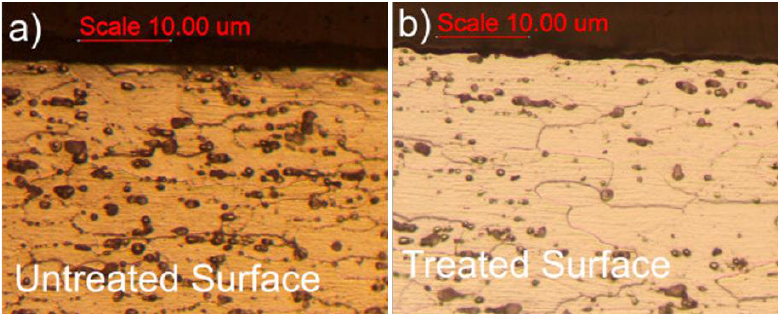
Figure 9. Optical images of ( a ) LSP-untreated and ( b ) LSP-treated surfaces [64]; with permission from Elsevier.